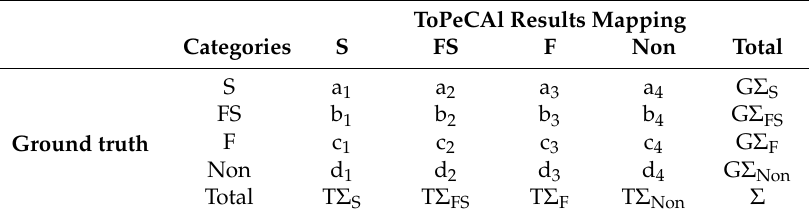
Table 4. The design of the Contingency Table comparing ToPeCAl mapping versus ground truth. Four categories ((S, FS and F, and non-combustion area (Non)) were assessed for both ground truth data and ToPeCAl